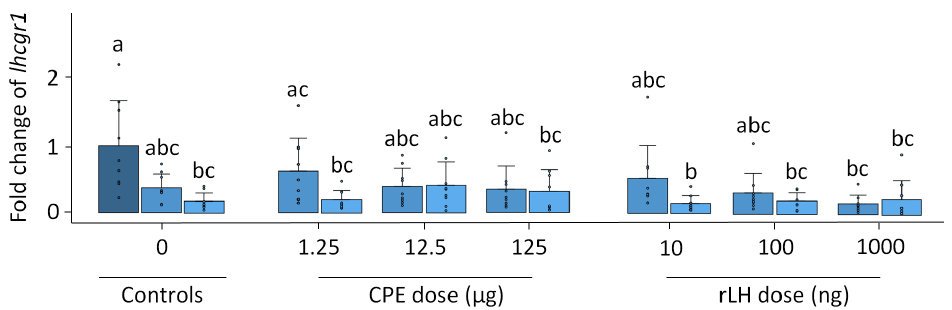
Figure 5. Expression of the luteinizing hormone receptor lhcgr1 when treated with various dosages of CPE (0, 1.25, 12.5 and 125 µg mL −1 ) and rLH (0, 10, 100 and 1000 ng mL −1 ) in vitro at the start of incubation (dark blue) and after 12 (mild blue) and 18 (light blue) hours of incubation. The receptor expression was normalized to the 0 h control and expressed as the fold change. The expression was compared between the time points and dosages of CPE and rLH. The expression of lhcgr1 decreased after 18 h of incubation when compared to the 0 h control. Bars with no overlap of letters are significantly different from each other ( p < 0.05). The data are presented as bar plots with the average ± standard deviation and individual data points as circles. The experiments were performed on N = 9 eels.